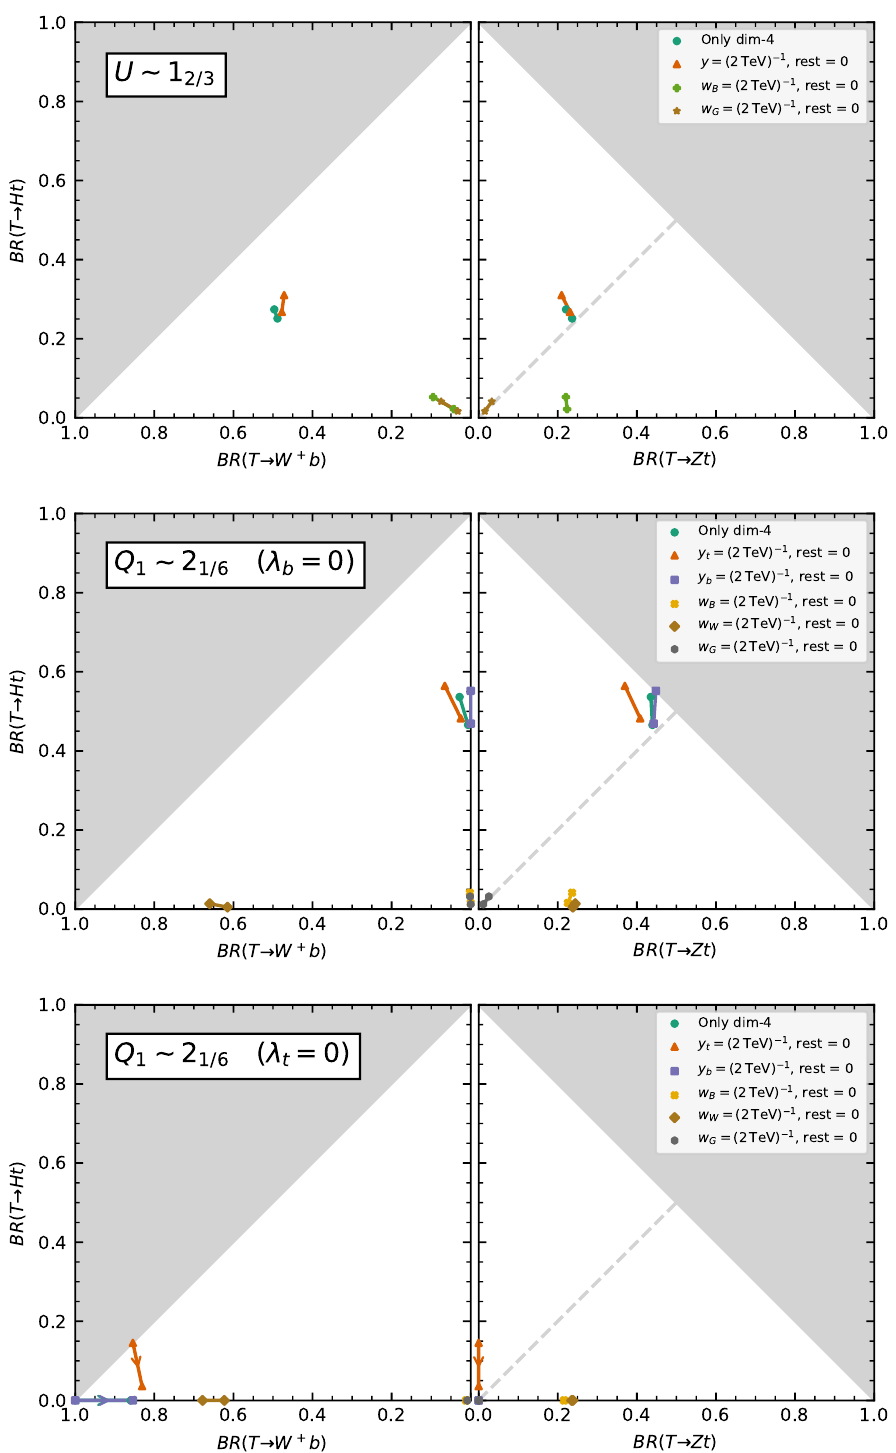
Figure 10 . Branching ratios of T into Ht , Zt and W + b for various values of the parameters in the U , Q 7 and Q 1 models. The dimensionless couplings (cid:21) are always chosen to saturate the corresponding electroweak precision bounds.